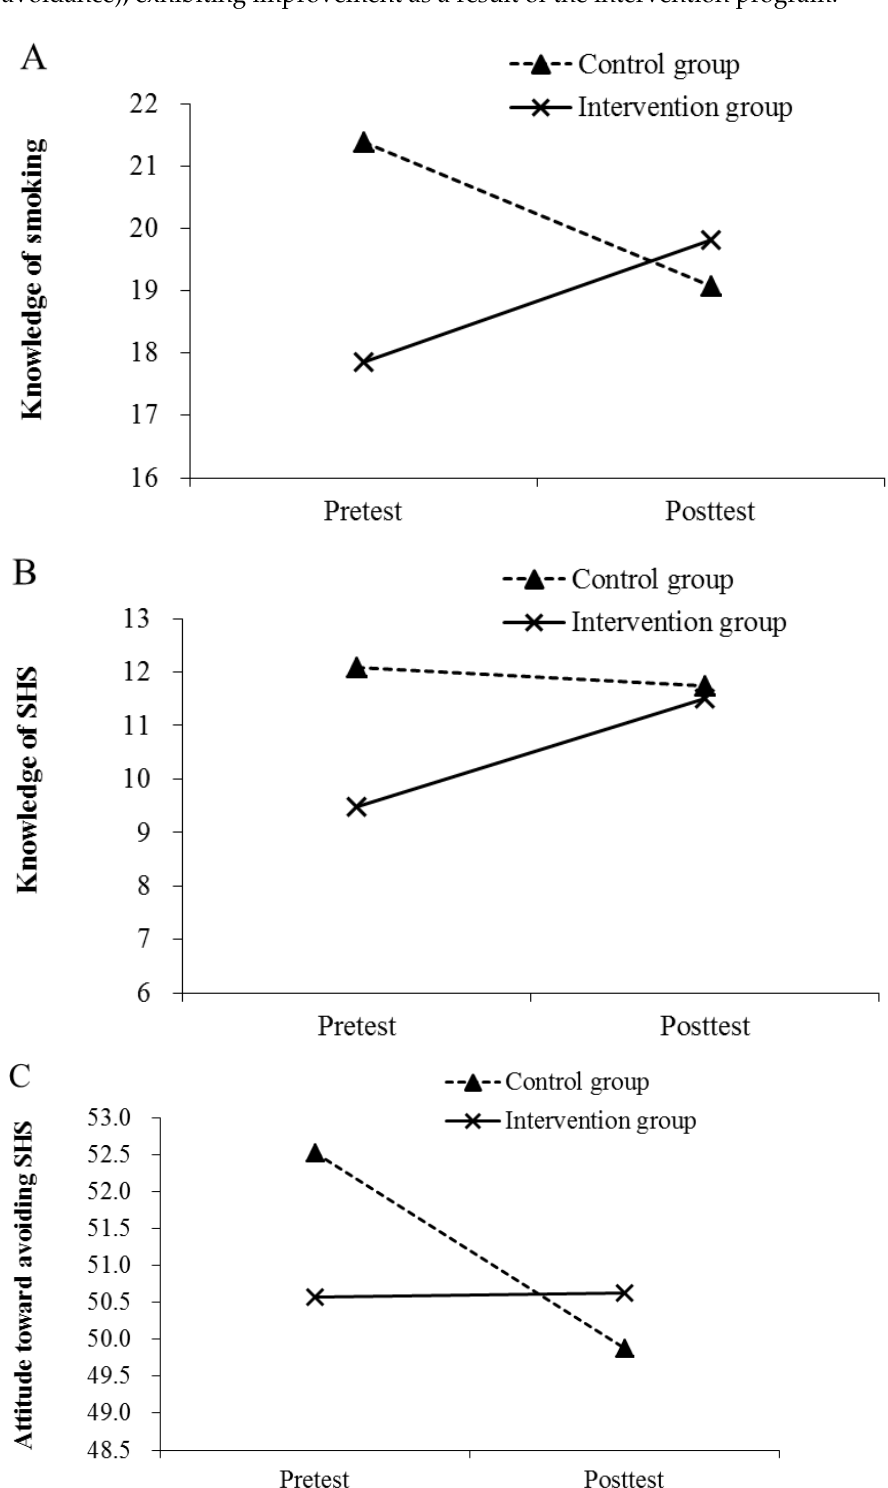
Figure 2. Mean score of ( A ) Knowledge of smoking, ( B ) Knowledge of SHS, and ( C ) Attitude toward avoiding SHS in the pretest and posttest for each group.